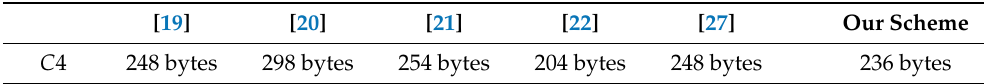
Table 5. Communication cost comparison